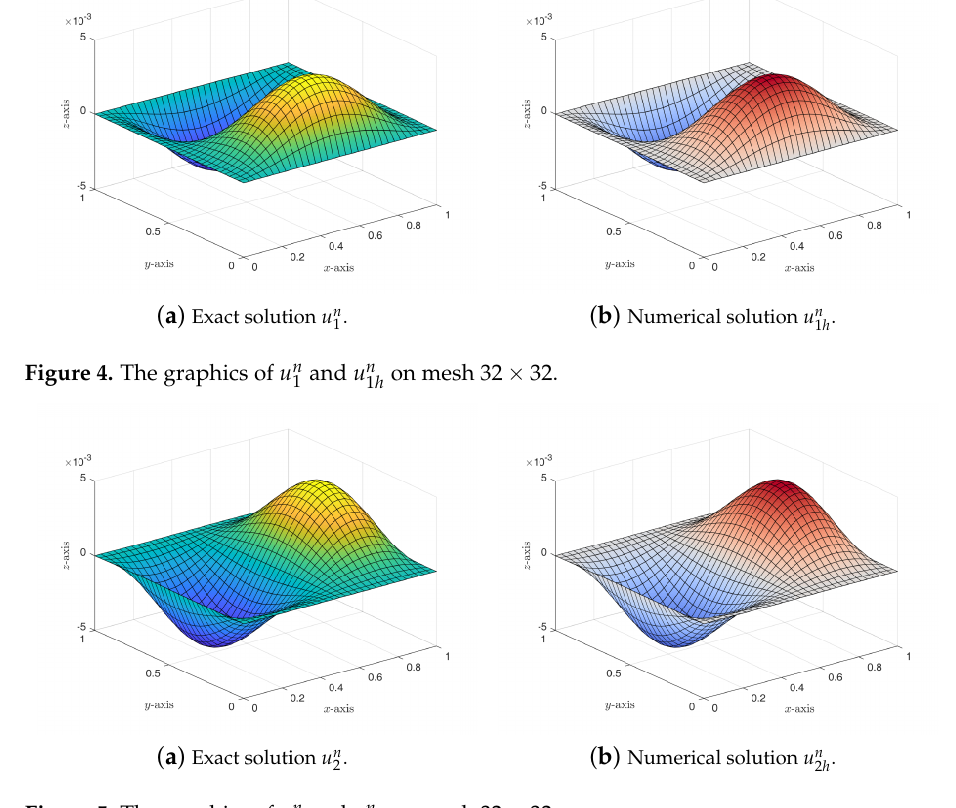
and u n on mesh 32 2 2 h